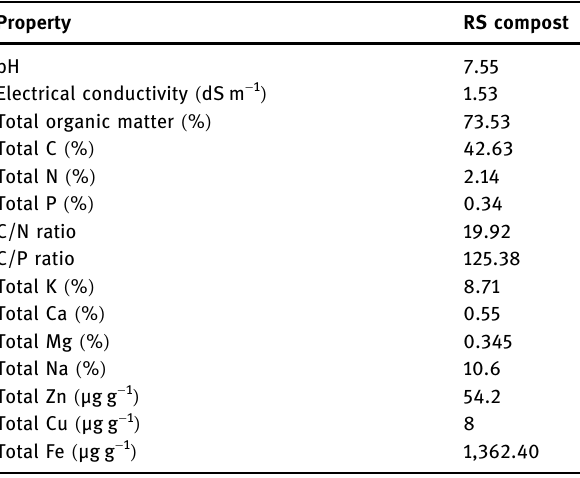
Table 2: Selected chemical properties of RS compost